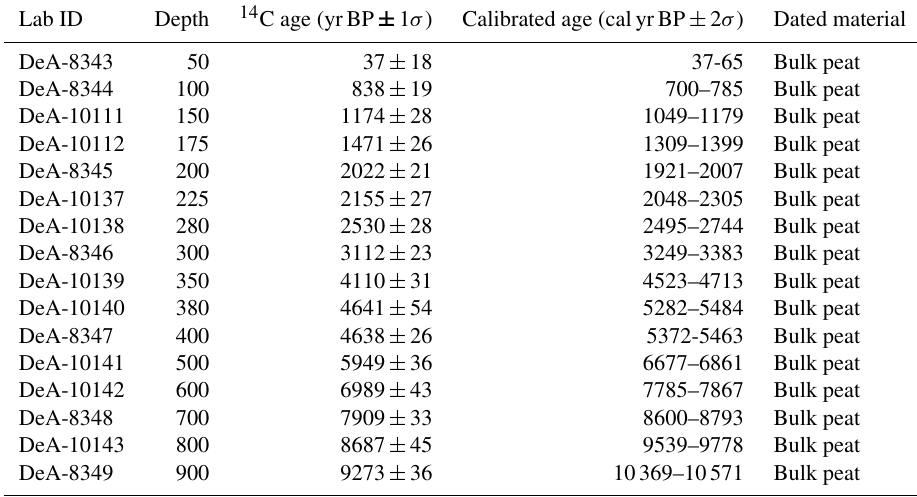
Table 1. Radiocarbon dates used to build the age model for the Mohos peat